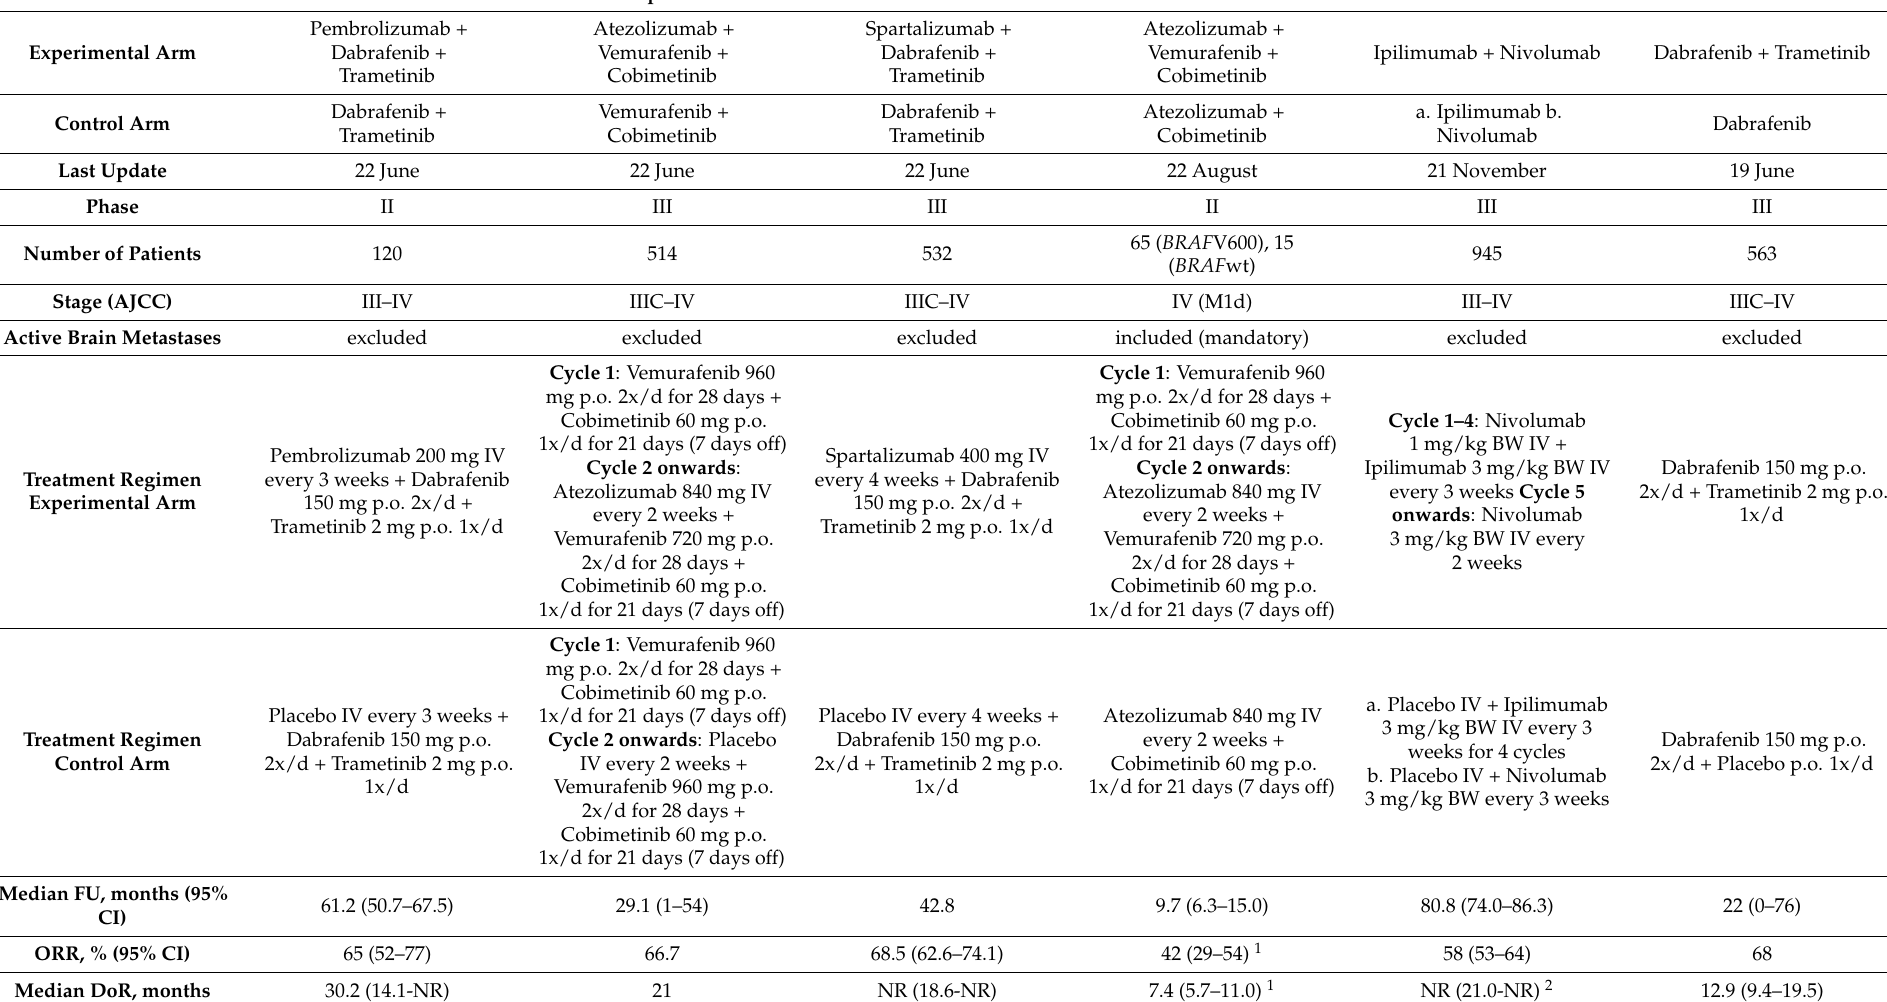
Table 1. Outcome data from clinical trials in BRAF V600 mutated